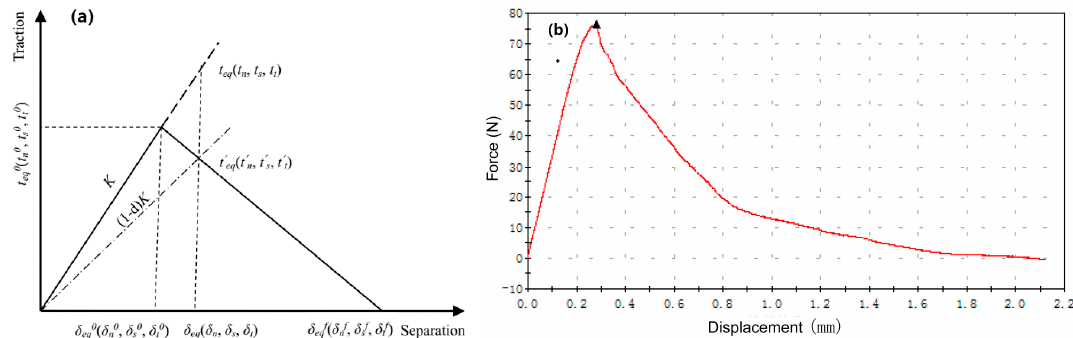
Figure 5. Schematic illustration of the traction ‒ separation law for the cohesive zone model ( a ) and force ‒ displacement curve of the fiber pullout test ( b ).